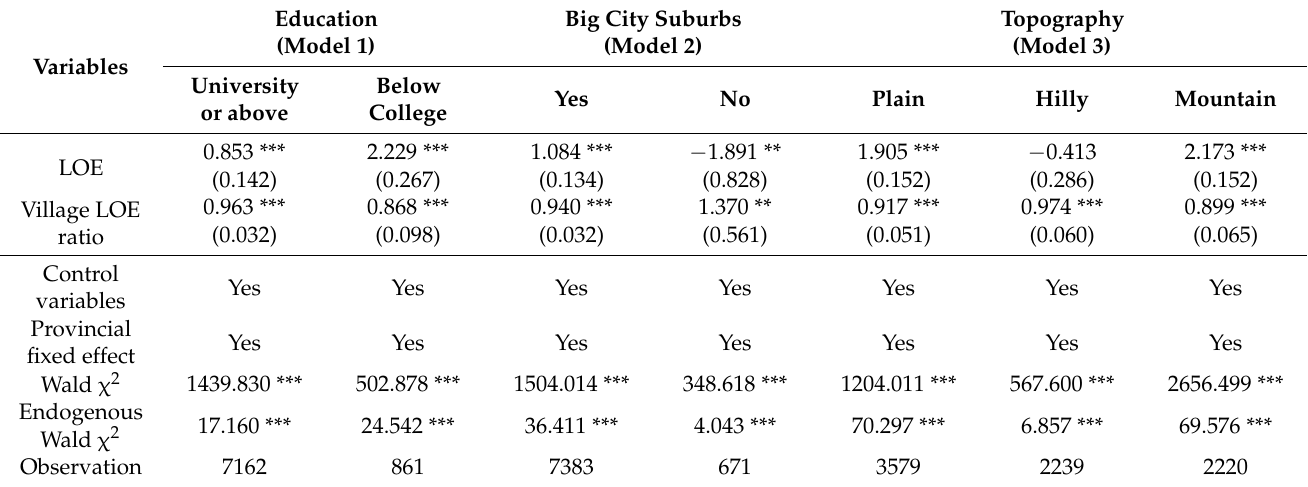
Table 3. Heterogeneity analysis